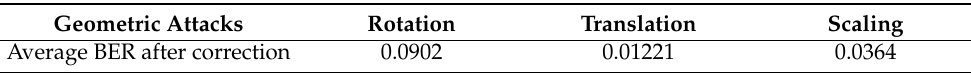
Table 8. The BER under geometric transformation correction. Geometric Attacks Rotation Translation Scaling Average BER after correction 0.0902